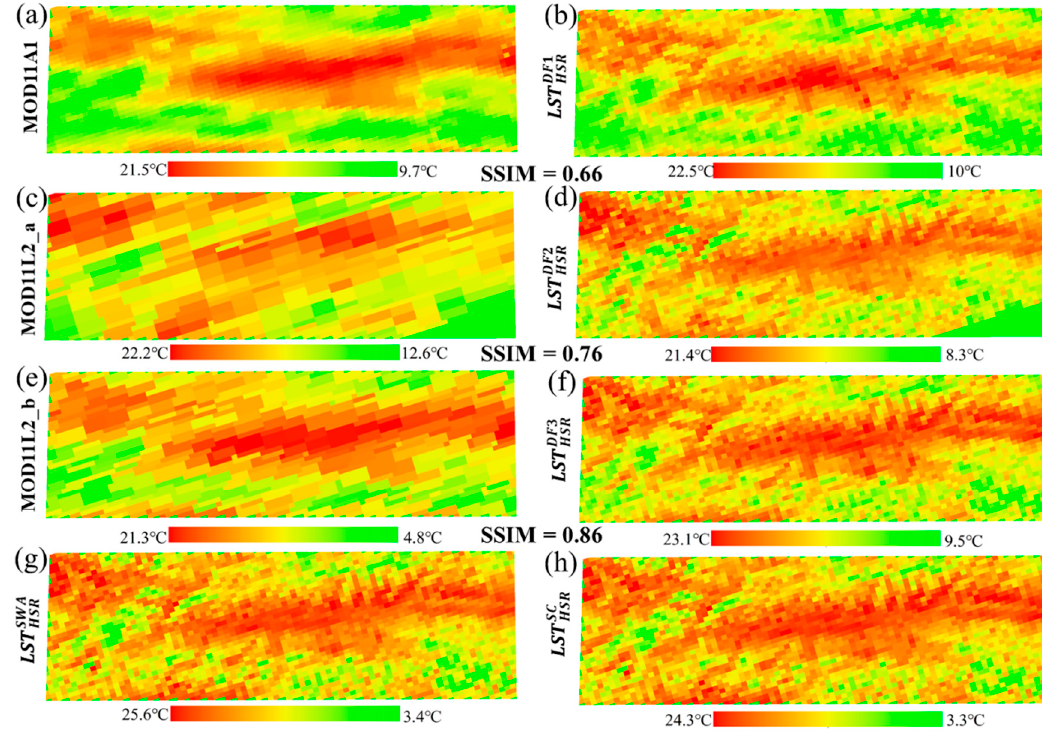
Figure 6. The spatial distributions of the MODIS LSTs ( a,c,e ), HSR fused LSTs ( b,d,f ), and reference LSTs ( g,h ) of Case 1 on 13 September, 2015. The HSR fused LSTs and reference LSTs are resampled to match the spatial resolution of MODIS LST.